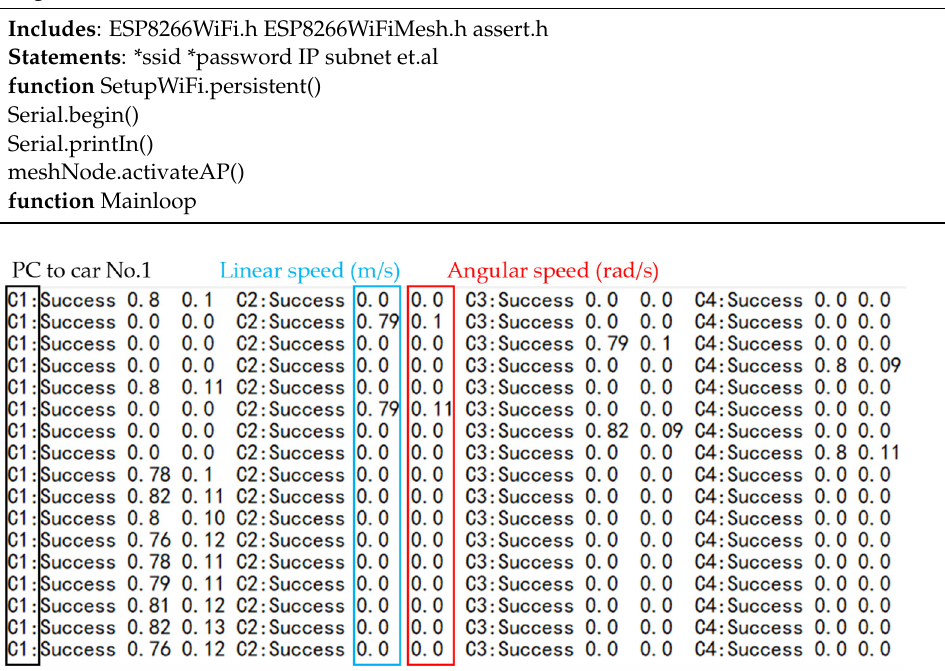
Figure 17. Motion information of the modular vehicles.